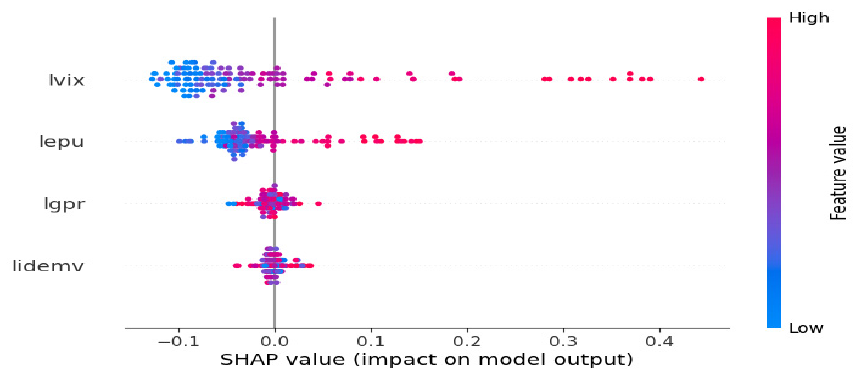
Figure 10. The XGBoost model: Feature importance during the pandemic (Daily frequency).